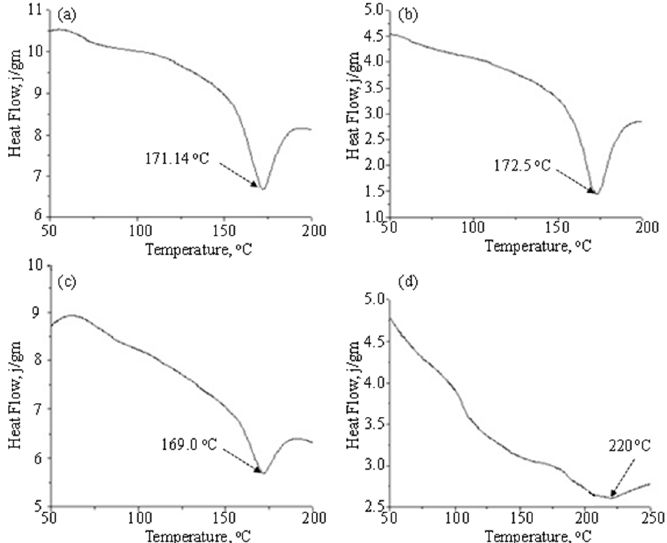
Figure 4. Melting behavior of styrene ‐ acrylonitrile ‐ blended PVDF membranes. ( a ) 100% PVDF; ( b ) 10% styrene ‐ acrylonitrile blend; ( c ) 60% styrene ‐ acrylonitrile blend; ( d ) 100% styrene ‐ acrylonitrile membranes. Appl. Sci. 2016 , 6 , 159 Hf Table 3. Melting point (Tm), melting enthalpy ( ) of membranes obtained from a differential scanning calorimeter (DSC).